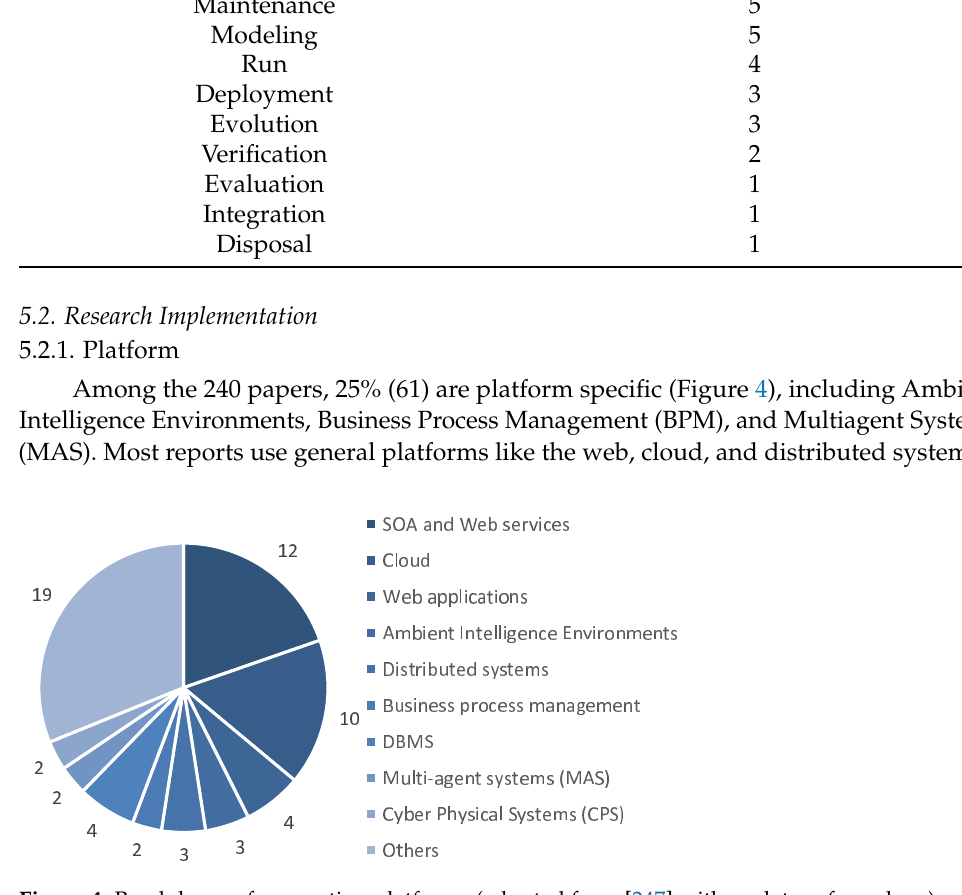
Figure 4. Breakdown of computing platforms (adopted from [247] with updates of